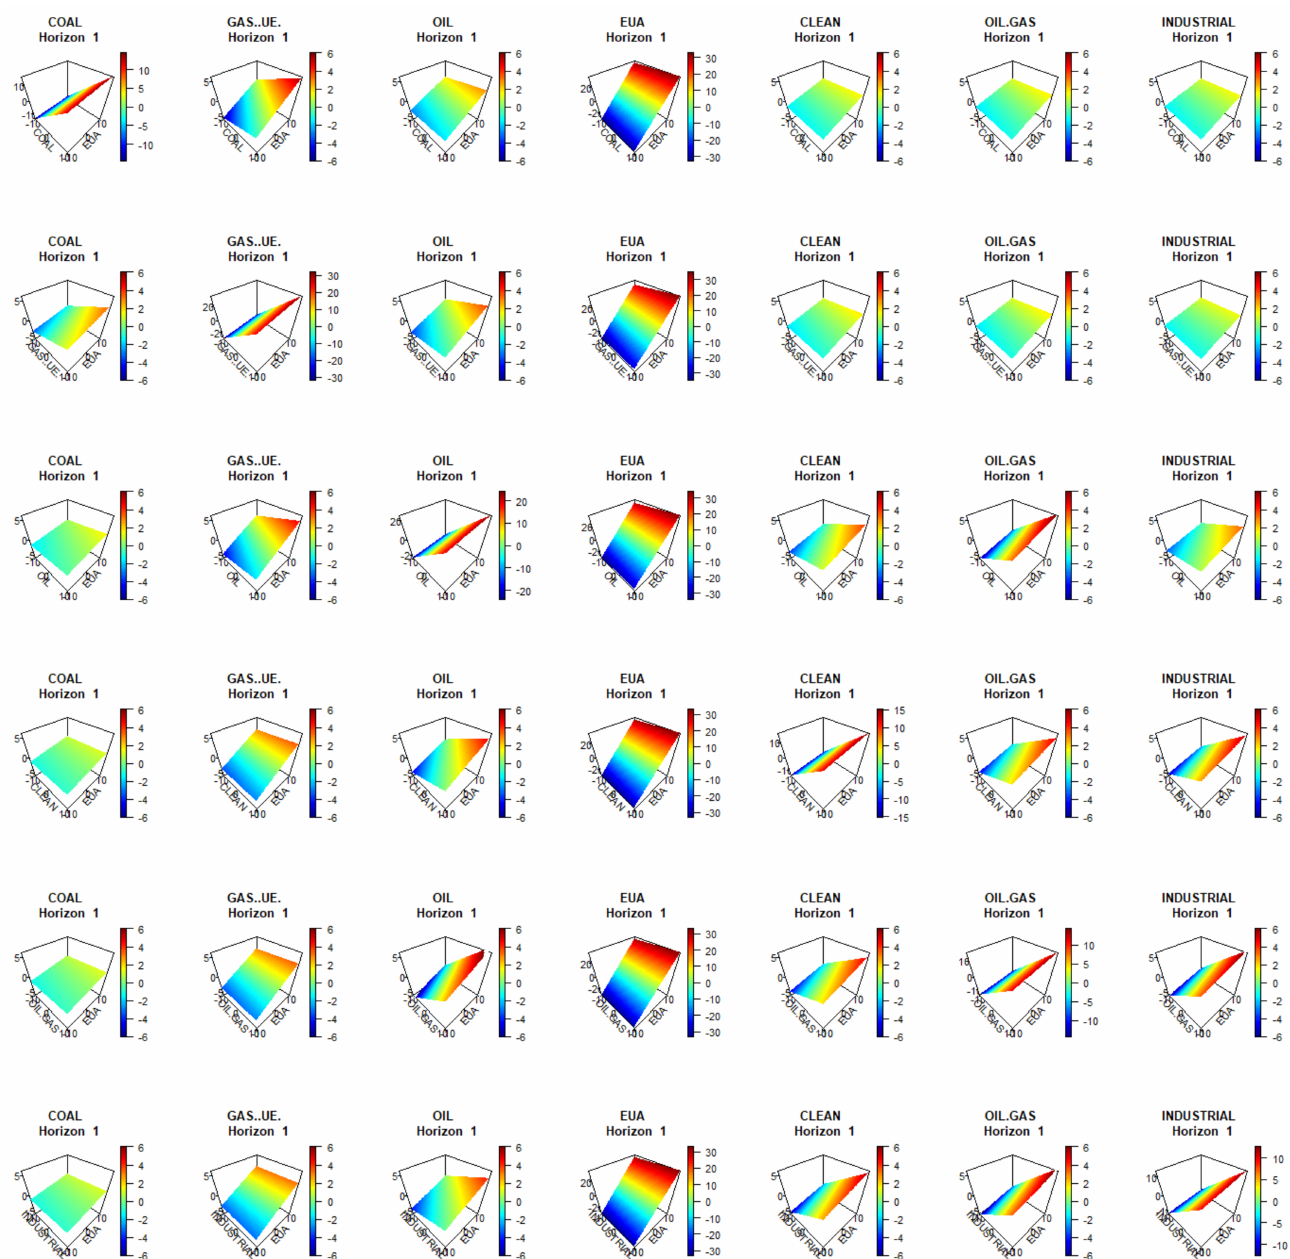
Figure 9. Matrix graph with the response surfaces of the conditional mean of all of the seven variables (by column) to bivariate impulses in all pairs of combinations of each variable with EUA (by